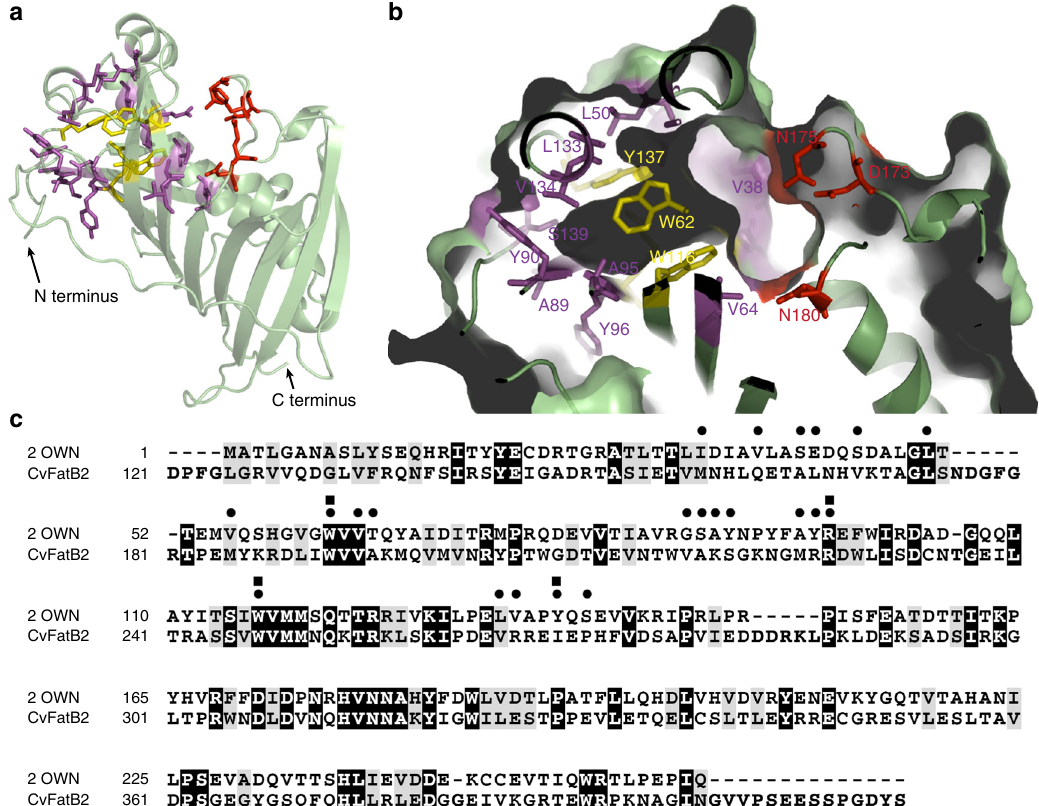
Fig. 4 Structural analysis of 2OWN and sequence comparison between 2OWN and CvFatB2. a Ribbon diagram of the experimentally determined crystal structure of L. plantarum acyl-ACP TE, 2OWN. Catalytic residues are shown as red stick models. The residues that form the acyl-binding cavity in the N- terminal hotdog domain are shown as magenta and yellow stick models. The four bulky residues that occupy more than 50% of the surface area of the acyl-binding cavity are shown as yellow stick models. b A magni fi ed view of the acyl-binding cavity in the N-terminal hotdog domain. c Sequence comparison of 2OWN and CvFatB2; identical residues are black-shaded, and conservative substitutions are gray-shaded. Residues forming the acyl-binding cavity are indicated by dots above the sequences, and the four bulky residues that account for more than 50% of the surface area of this cavity are indicated by squares above the